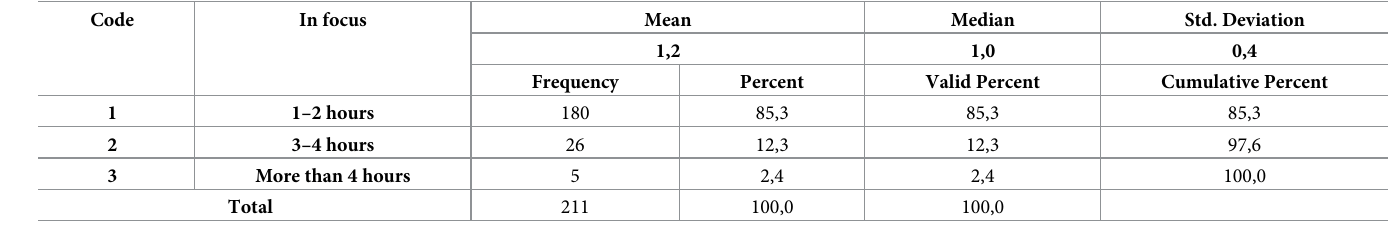
Table 10. Duration in following the webinar event.